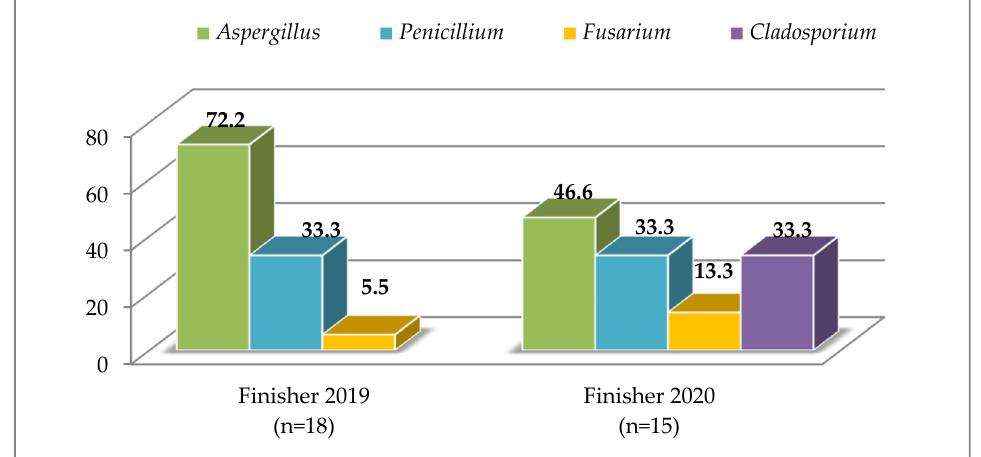
Figure 5. Proportion (%) of potentially toxigenic fungal genera in positive finisher compound feed samples (n—number of positive samples).